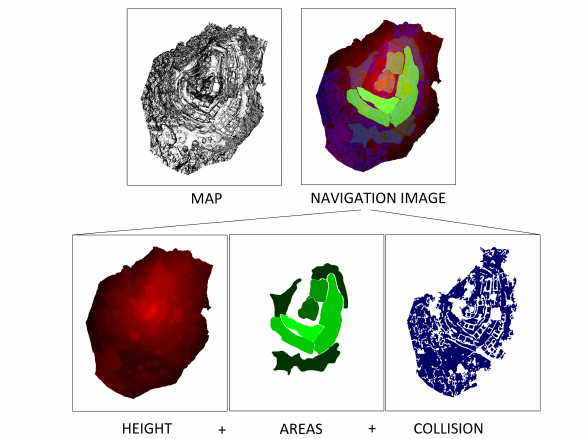
Figure 4: The visualization webpage interface. On left: the 3D view, currently in bird’s eye view mode, with the point of interest shown by the 3D locator. On top right: the current area and room name, tracked using the location channel of the map. On middle right: the minimap, graphically showing the current position. On bottom right: the current position of the user, expressed in this specific case as relative coordinates with respect to a local origin defined in a GIS